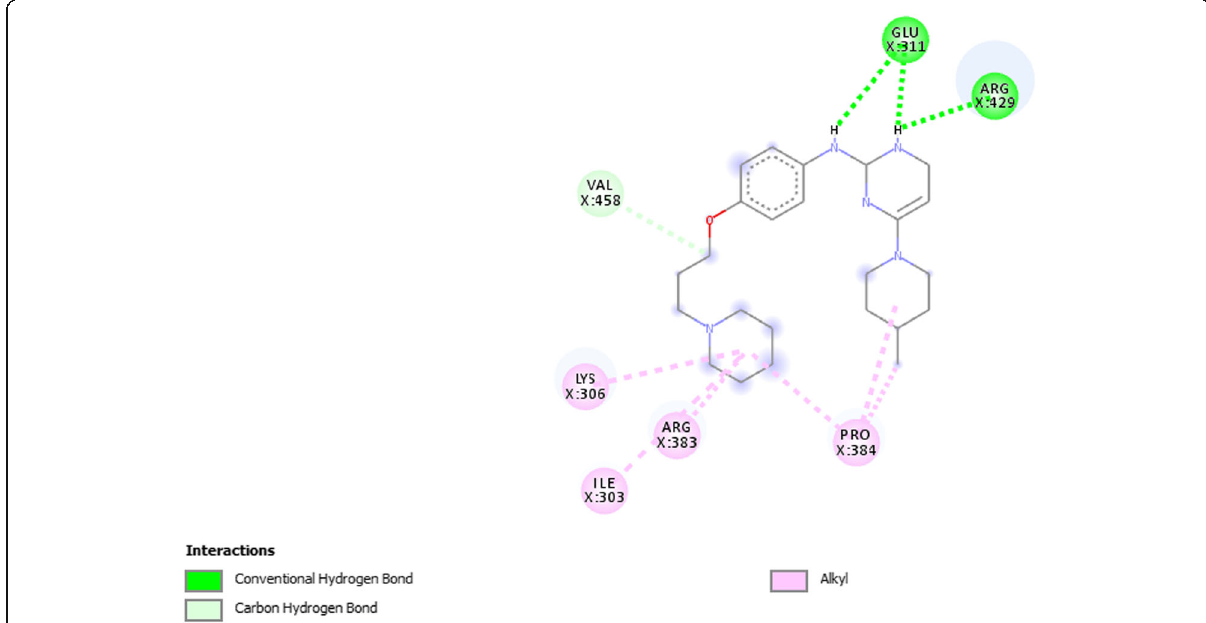
Fig. 6 Receptor – ligand interaction of complex 15 on a 2D